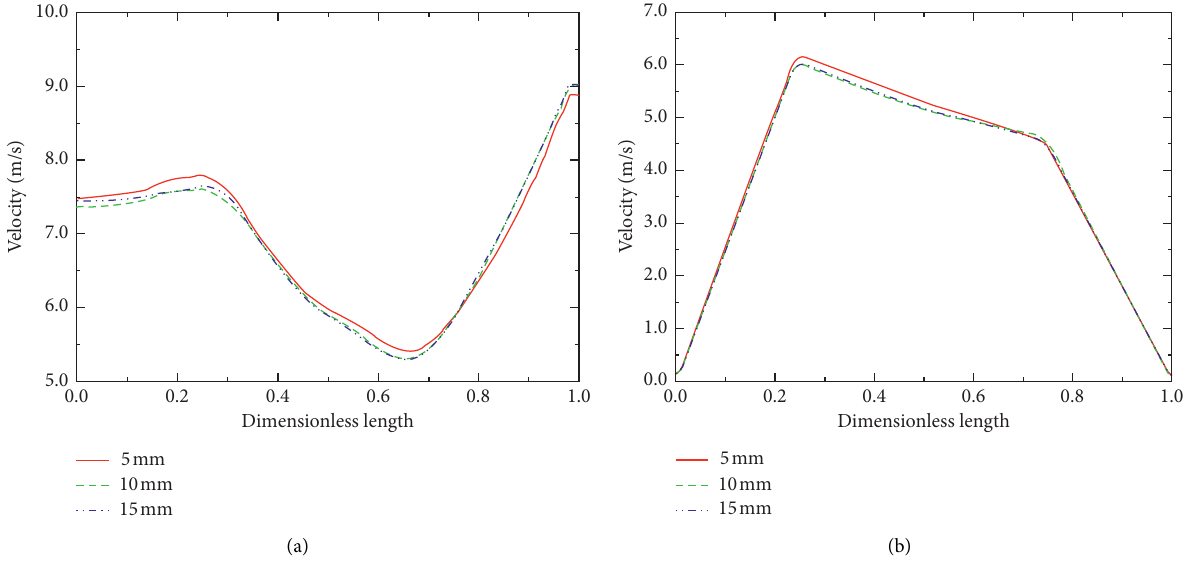
Figure 16: Relative velocity curves in the impeller: (a) from the inlet to the outlet and (b) from the front shroud to the rear